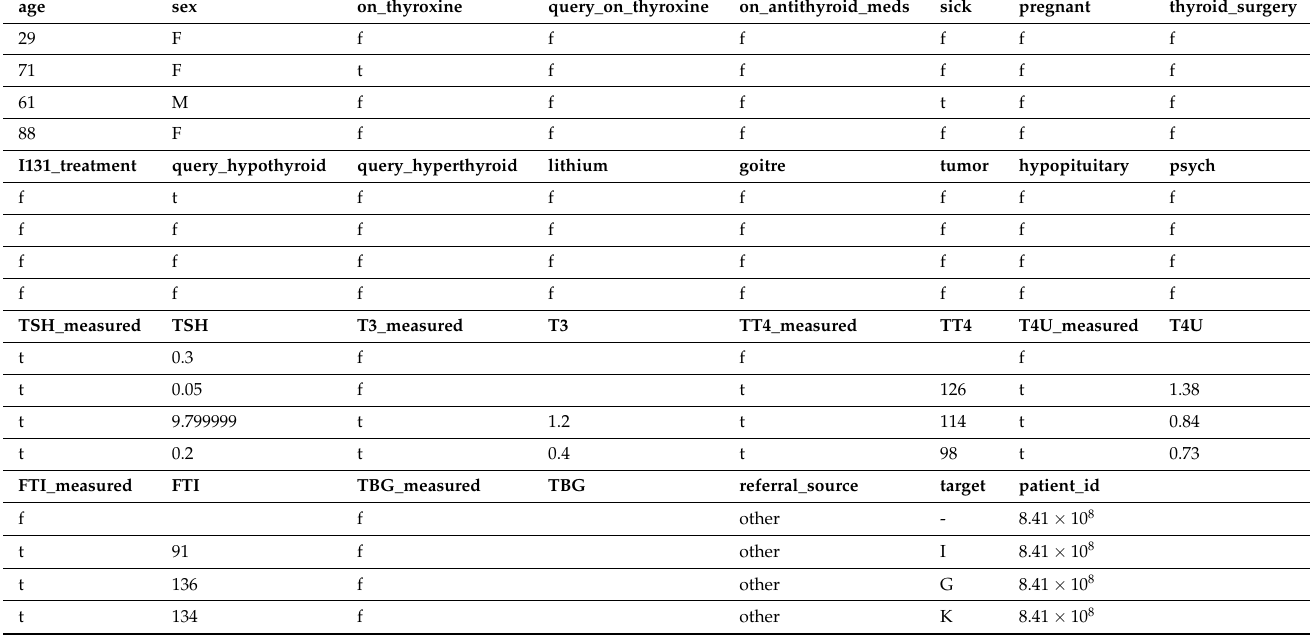
Table 6. Sample of dataset.